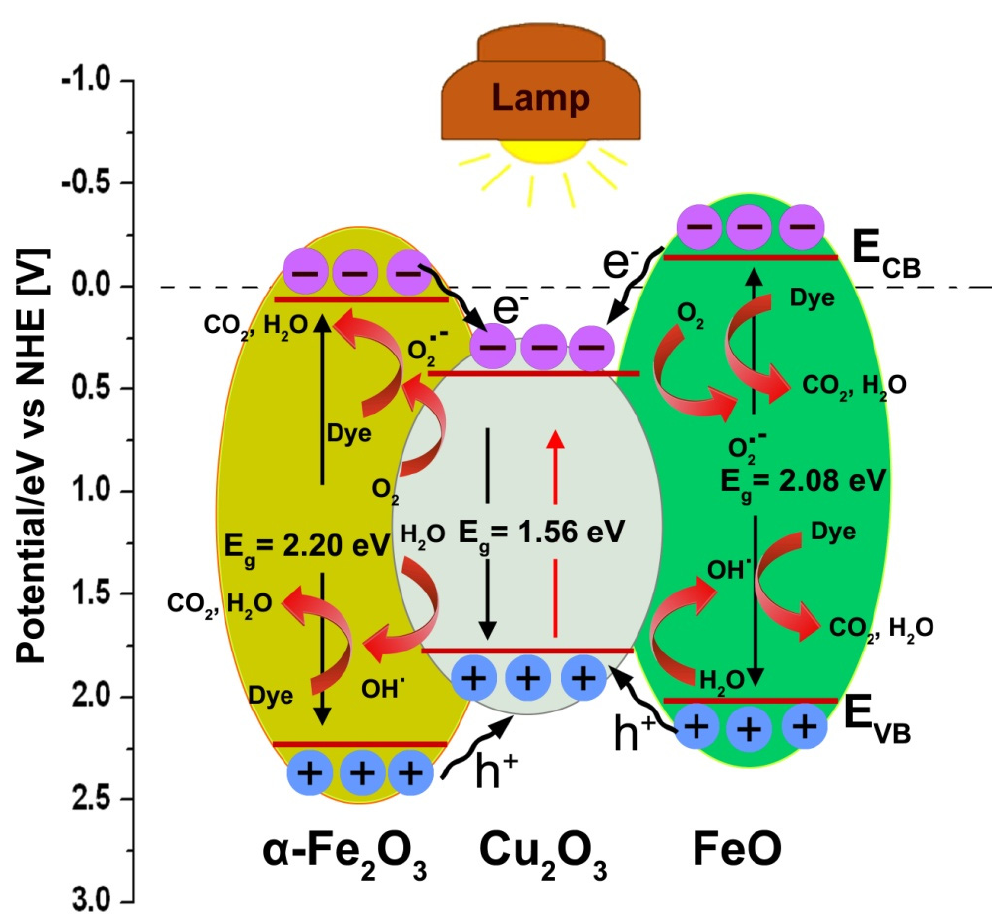
Figure 10. Schematic diagram for photocatalytic mechanism for S2.